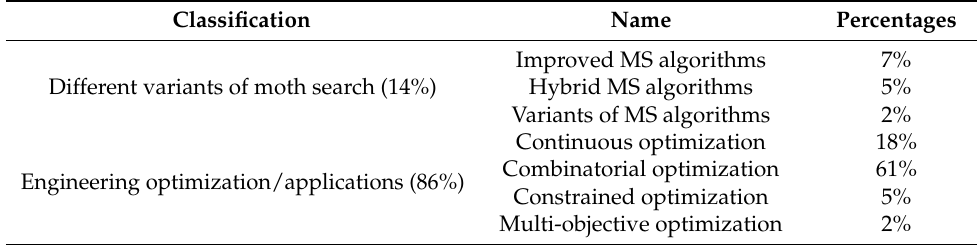
Table 1. Classification proportions for